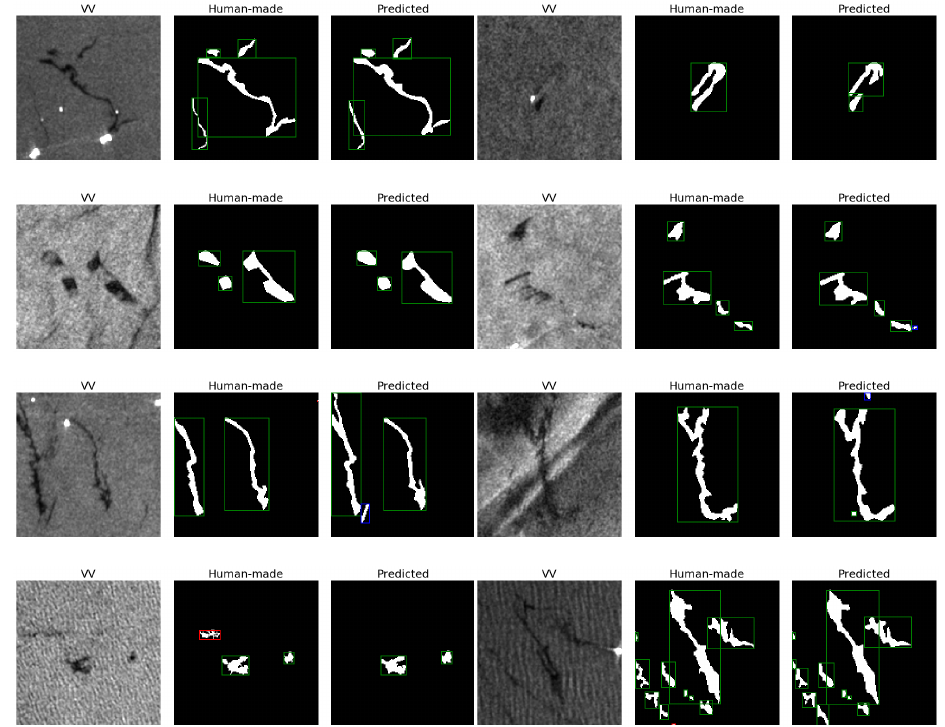
Figure 7. Examples of segmentation masks predicted by the OFCN on the validation set of D 2 . From left to right: the VV input channel, the mask made by the human operator, the OFCN output thresholded at 0.5 (values ≤ 0.5 → 0, values ≥ 0.5 → 1). Green bounding boxes are TP (the oil spill appears both in the human-made and the predicted mask), blue boxes are FP (the OFCN detects an oil spill that is not present in the human-made mask), and red boxes are FN (the oil spill is in the human-made mask but is not detected by the